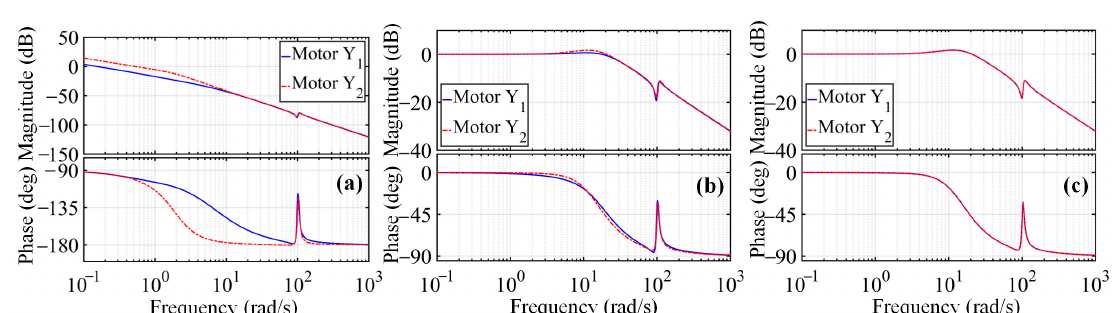
Figure 7. Comparison of the dual-motor system FDC: ( a ) open-loop control; ( b ) closed-loop control; ( c ) closed-loop control with the designed FDC-UM.